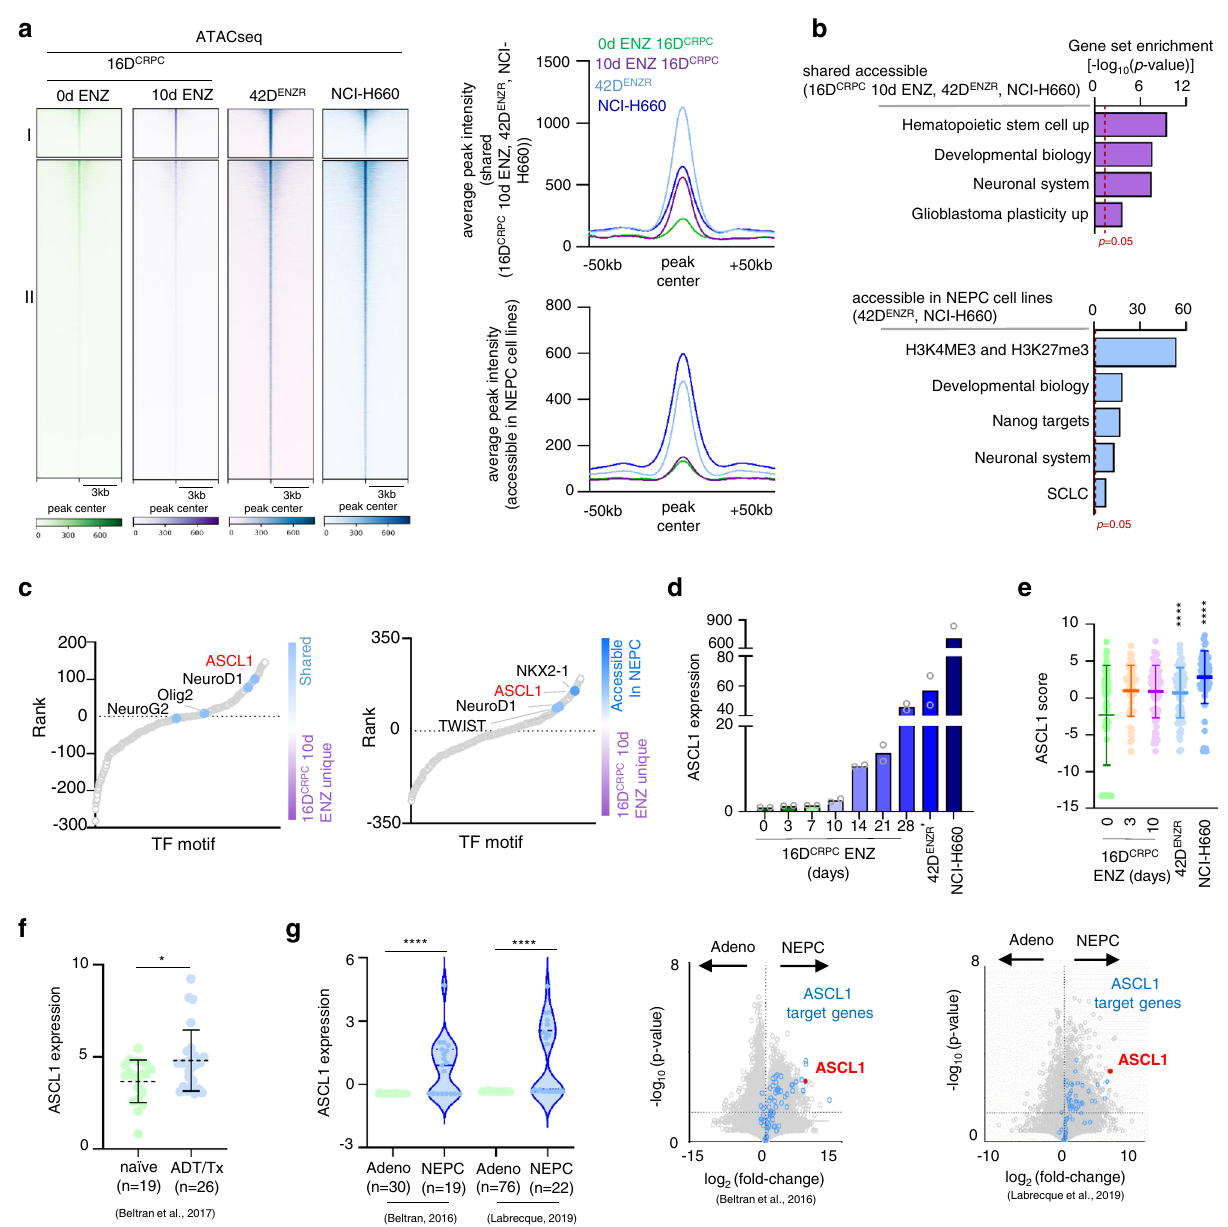
Fig. 2 Enzalutamide-induced epigenetic plasticity leads to neuronal differentiation. a Heatmap showing chromatin accessibility comparing 16D CRPC 10 days ENZ-treated unique accessible regions to neuroendocrine prostate cancer (NEPC) (left) average signal pro fi le (right). b GSEA in accessible shared regions (top) and accessible in NEPC (bottom). Dotted line represent p = 0.05, statistical analysis was performed using a hypergeometric test. See also Supplementary Fig. 2. c TF binding motifs surrounding accessible chromatin in shared accessible region (left) accessibility in NEPC (right) vs. unique to 16D CRPC 10 days ENZ-treated, ranked based on differential p -value. Each dot represents a motif. Statistical analysis was performed using a cumulative hypergeometric test. d ASCL1 mRNA expression normalized to GAPDH ( n = 2 biologically independent samples). e ASCL1 score reported as log2FPKM mean ± SD. (16D CRPC n = 3, 16D CRPC 3d ENZ n = 1, 16D CRPC 10d ENZ n = 1, 42D ENZR and NCI-H660 n = 3 biologically independent samples. 42D ENZR and NCI-H660 p < 0.0001; two-tailed p -value). f ASCL1 expression presented as normalized read counts in serial sections from naïve and neoadjuvant androgen-deprivation therapy (ADT)/TAX-treated prostate tumors 21 . Each dot represent individual patient. Data shown as mean ± SD, with signi fi cance assessed using a two-tailed unpaired t-test, p = 0.0135. g ASCL1 expression reported as log2TPM in adenocarcinoma (Adeno) and NEPC 12, 15 cohorts. Violin plots show median (middle solid line), quartiles as dotted lines and interquartile range, each dot represent a patient, with signi fi cance assessed using a two-tailed unpaired t-test. (Beltran et al. Adeno n = 30 and NEPC n = 19; and Labrecque et al. Adeno n = 76 and NEPC n = 22 patients) (left). Volcano plot shows expression and activity of ASCL1 in Beltran and Labrecque cohorts 12, 15 . Each dot represents a gene, with “ ASCL1 signature ” (blue) and “ ASCL1 ” (red) highlighted. Dotted line represent p = 0.05, statistical analysis was performed using a hypergeometric test (right). Source data are provided as a Source Data fi